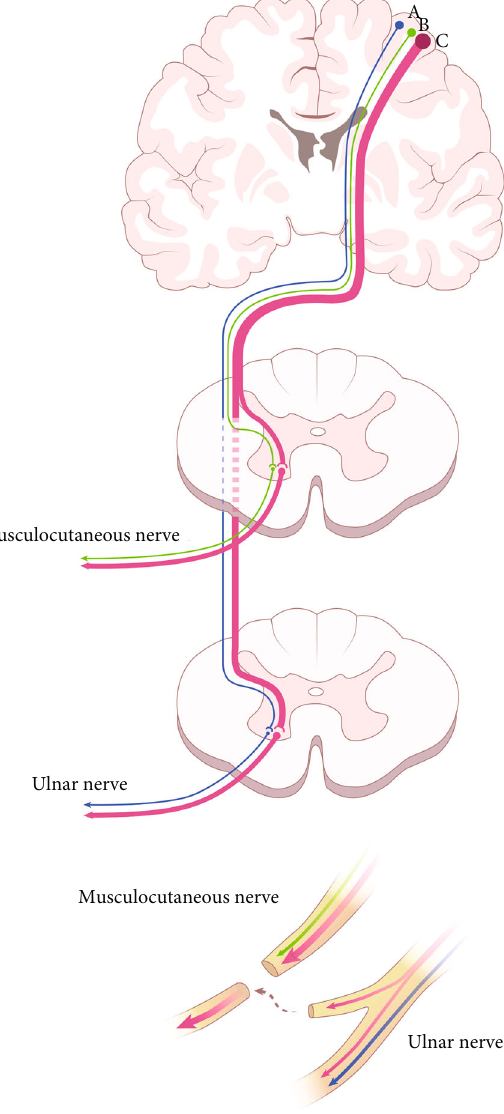
Figure 1: Neuroplasticity of the motor cortex for excellent clinical outcomes of Oberlin ’ s procedure. Corticospinal neurons (corticospinal projection A, B, and C) in the primary motor cortex of layer V projecting into the motor neurons in the spinal cord are the ultimate descending pathways responsible for movement control. A portion of corticospinal projections (corticospinal projection C) can simultaneously connect the ulnar (donor nerve) and the musculocutaneous nerves (acceptor nerve). Hence, the motor command of elbow fl exion can quickly be transmitted downward along the common pathway Corticospinal projection C to the ulnar nerve after Oberlin ’ s